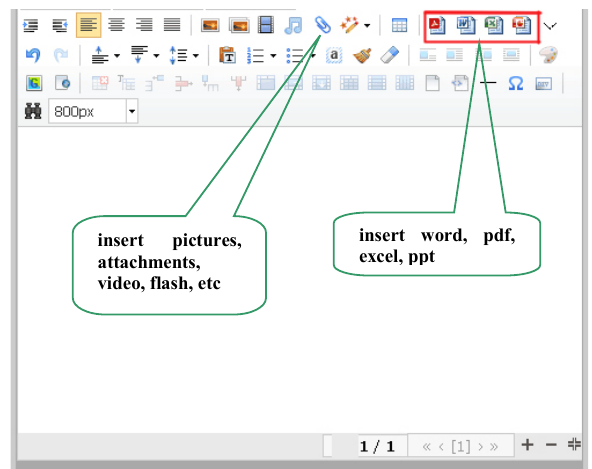
Figure 1. Visual background editing